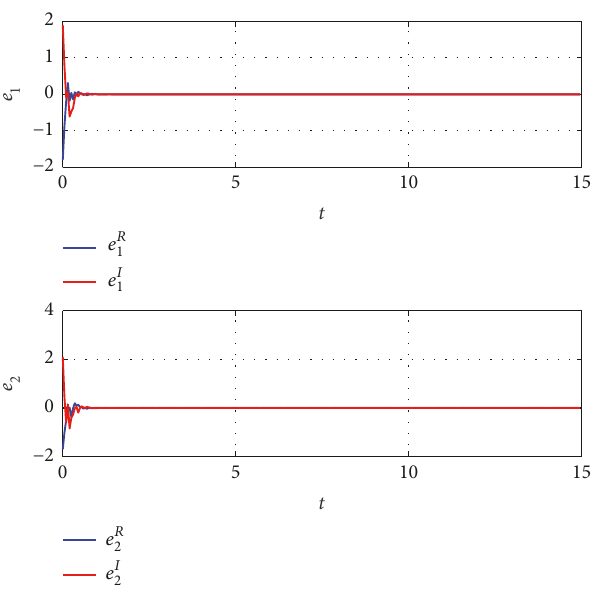
Figure 8: Time responses of synchronization errors 𝑒 1 and 𝑒 2 under controller for example